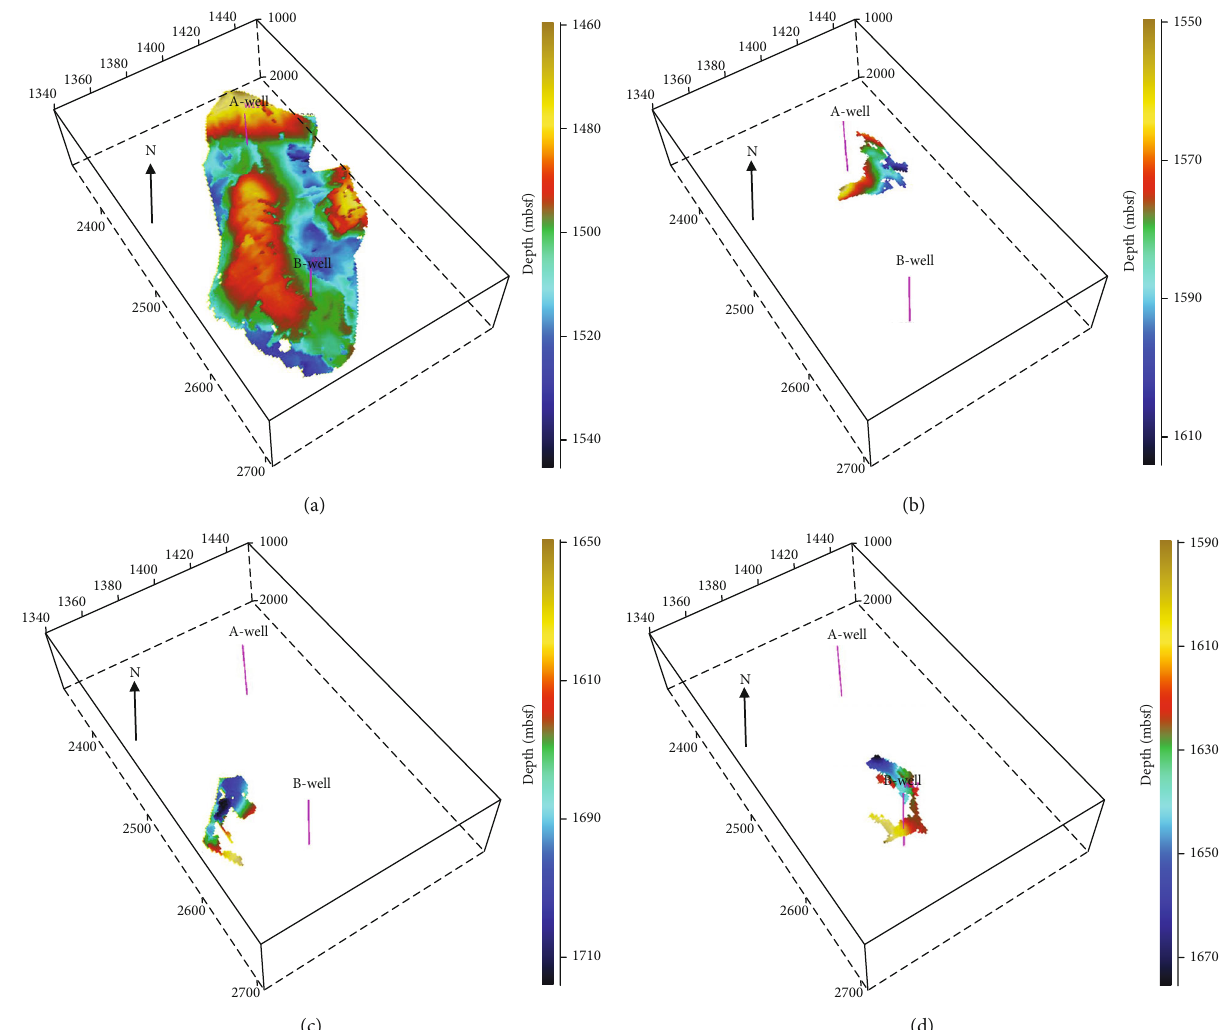
Figure 13: Three-dimensional spatial distribution of the main free gas reservoirs in the A-B ore body.